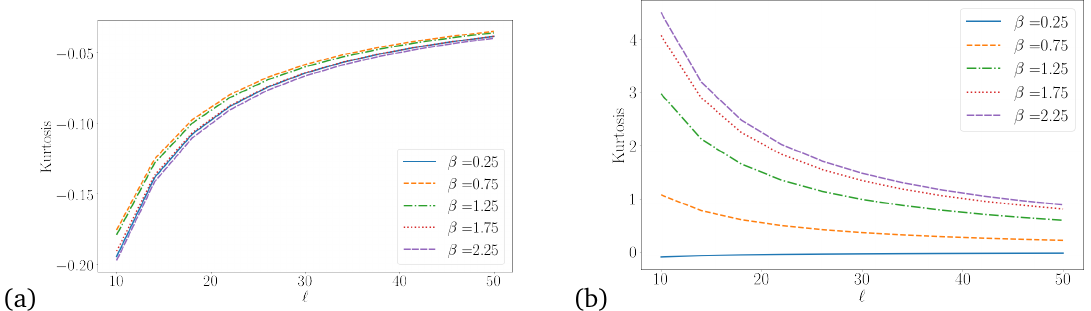
Figure 3: Excess kurtosis as a function of subsystem size (cid:96) for several temperatures and (a) h = 0.5 and (b) h =